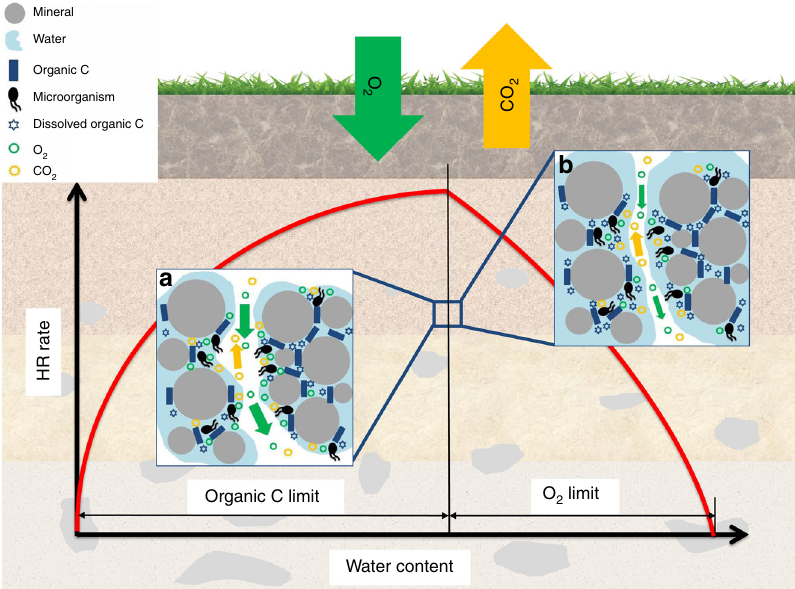
Fig. 1 The macroscopic moisture function, f m , and its links to microscale processes controlling heterotrophic respiration (HR) in soils. The red curve qualitatively describes the soil HR – moisture relationship, f m , in soils. The inset conceptual fi gures depict the microscale processes controlling soil HR under dry conditions ( a ), in which HR rate is limited by the bioavailability of organic carbon (C), and under wet conditions ( b ), in which HR rate is limited by O 2 supply, respectively. The processes controlling the bioavailability of organic C and O 2 include the desorption of soil-adsorbed organic C, diffusion of dissolved organic C and O 2 , and exchange between dissolved and gaseous O 2 . See Methods section for the details of f m and the microscale